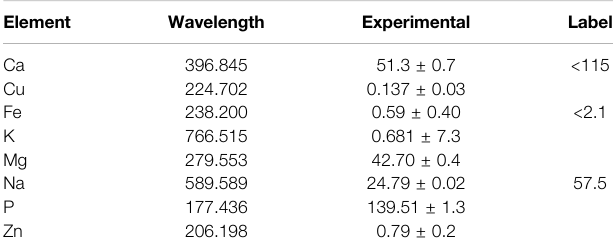
TABLE 5 | Elemental analysis of phytopigment analysis with respective wavelengths and observed experimental values by ICP-OES AVIO 200 with reference values in mg/mL.